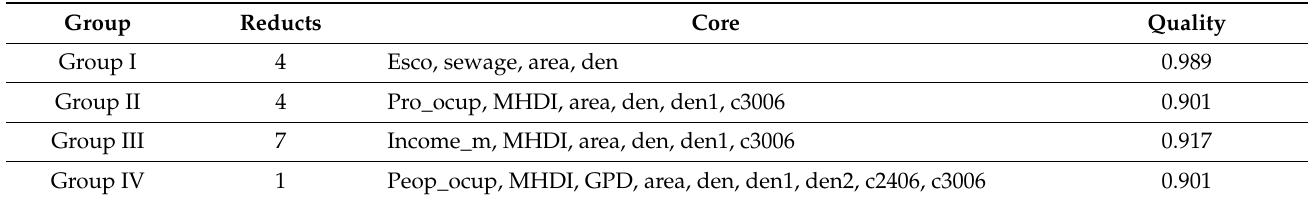
Table 7. Parameters generated via DRSA in relation to reference